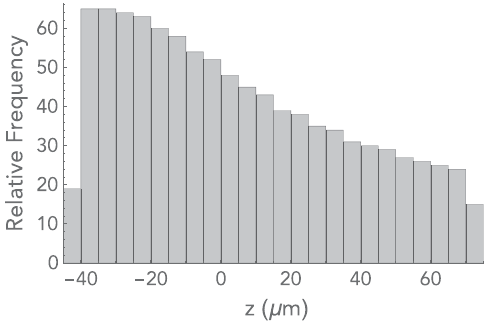
FIG. 16. Histogram of the density of electron trajectories at the end of the compressor, corresponding to the gray vertical line in Fig.